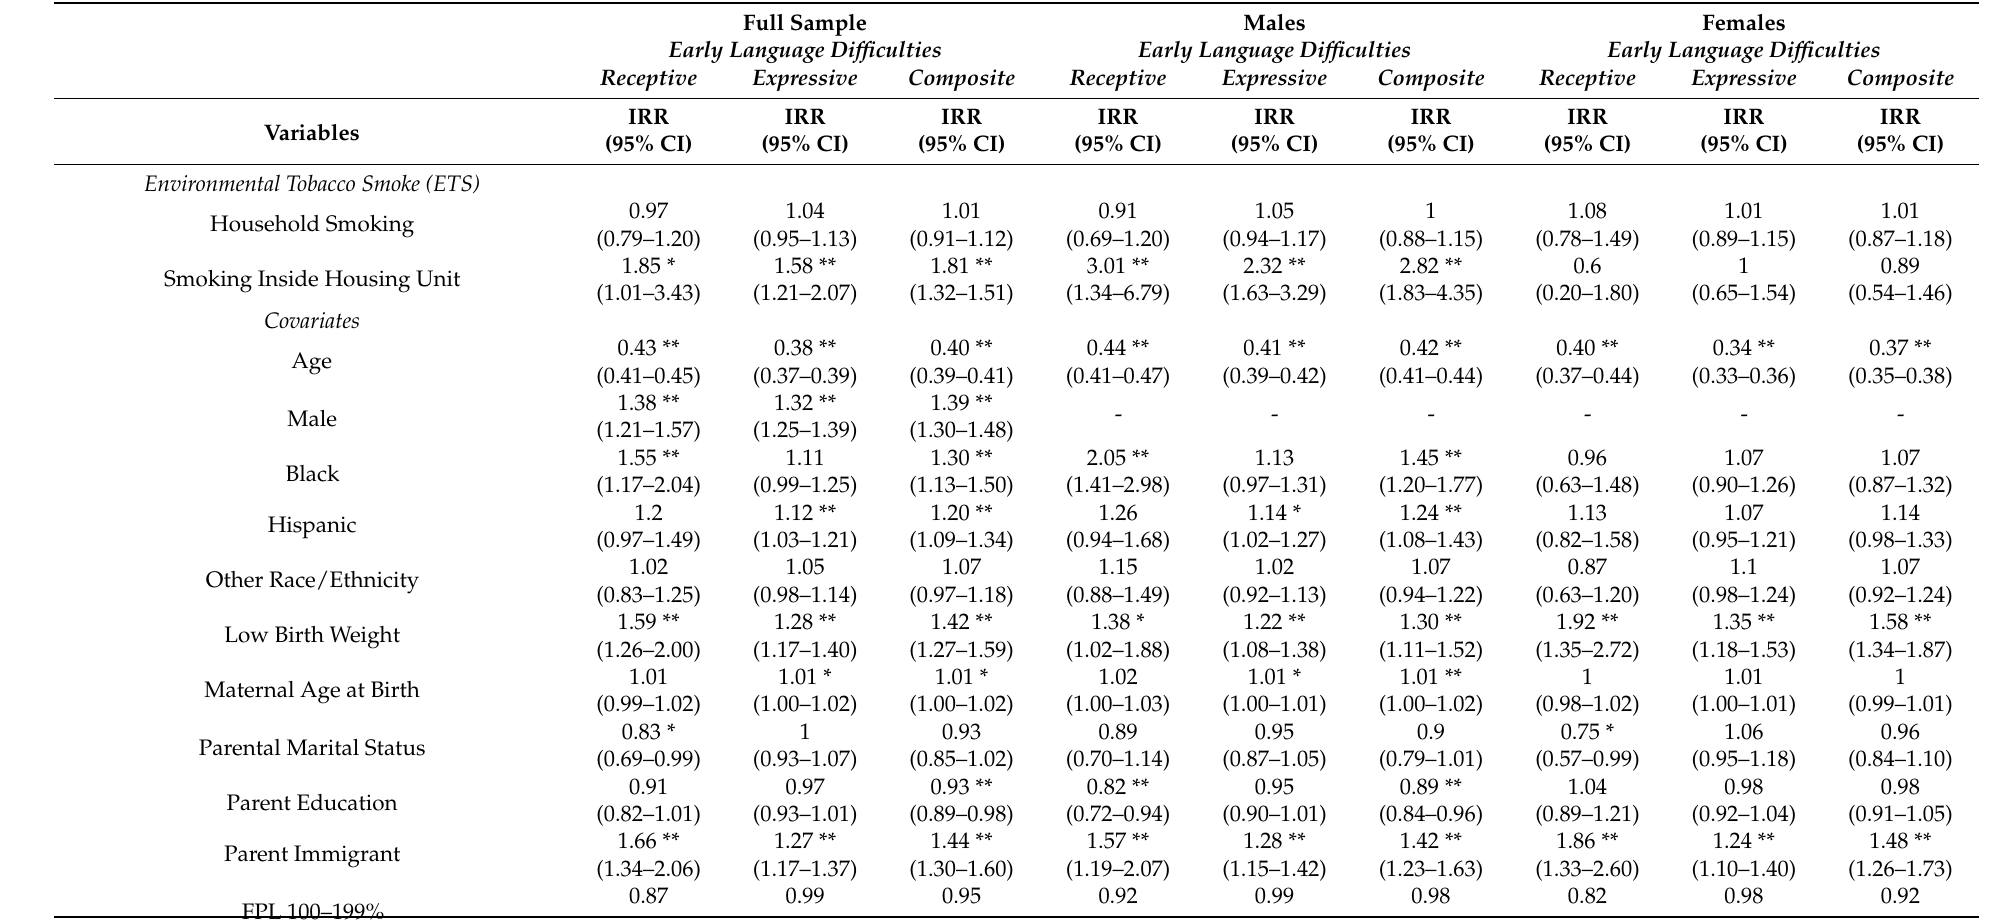
Table 2. Negative binomial regression of the association between environmental tobacco smoke (ETS) and early language